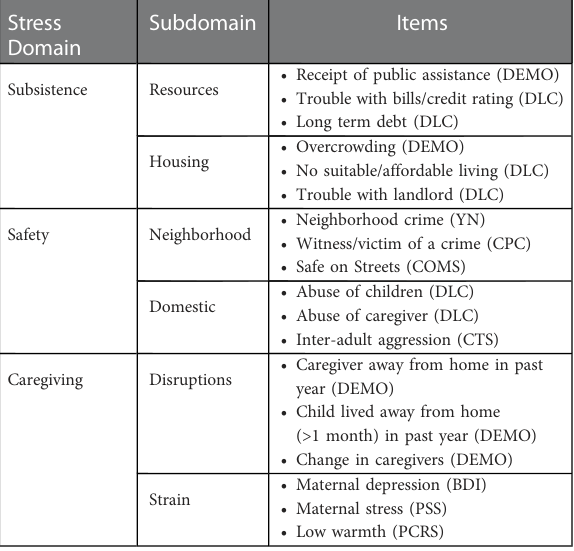
TABLE 1 Items within each stress